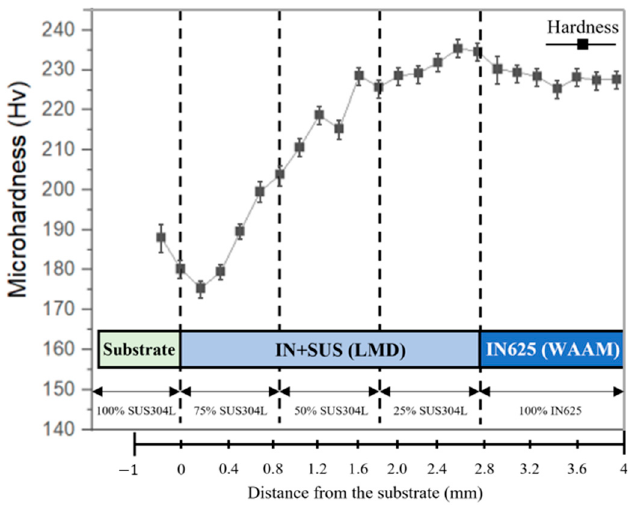
Figure 10. Microhardness distribution along the deposition